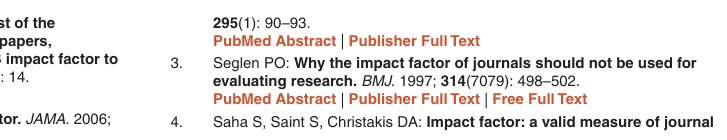
Table S1: Example of IFc calculation for Open Abdomen Congress 2016, in comparison with IFc for hypothetic Acute Leukemia Congress with the same